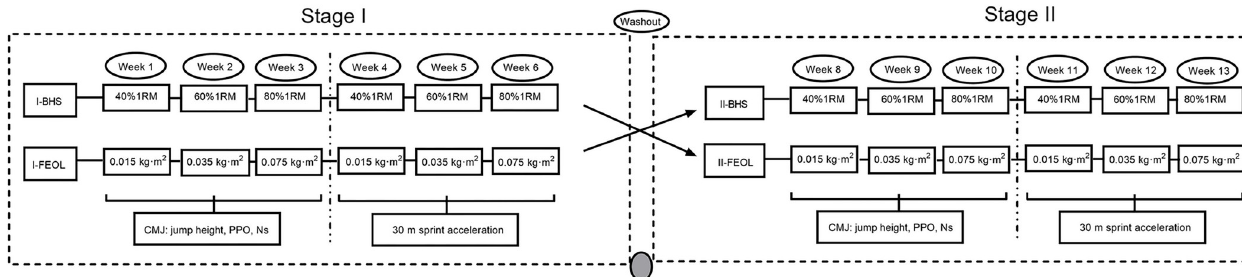
Fig 1. Flowchart of the experiment.